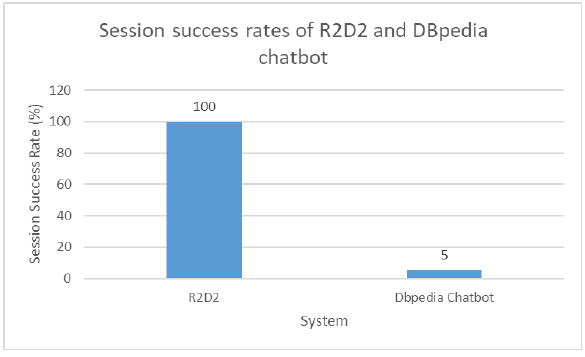
Figure 3. Session success rates of R2D2 and DBpedia chatbot.